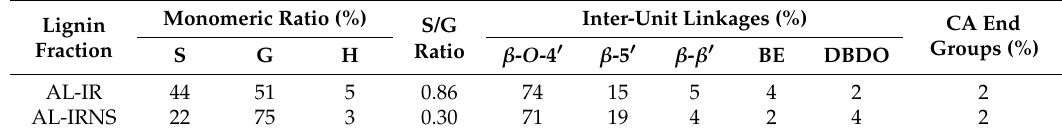
Table 4. Monomeric ratios and ratios of inter-unit linkages of the isolated acidolysis lignins from Iroko (AL-IR) and Iroko–Norway spruce (AL-IRNS), estimated on base of the cross-peaks integrals of the respective 2D NMR spectra.